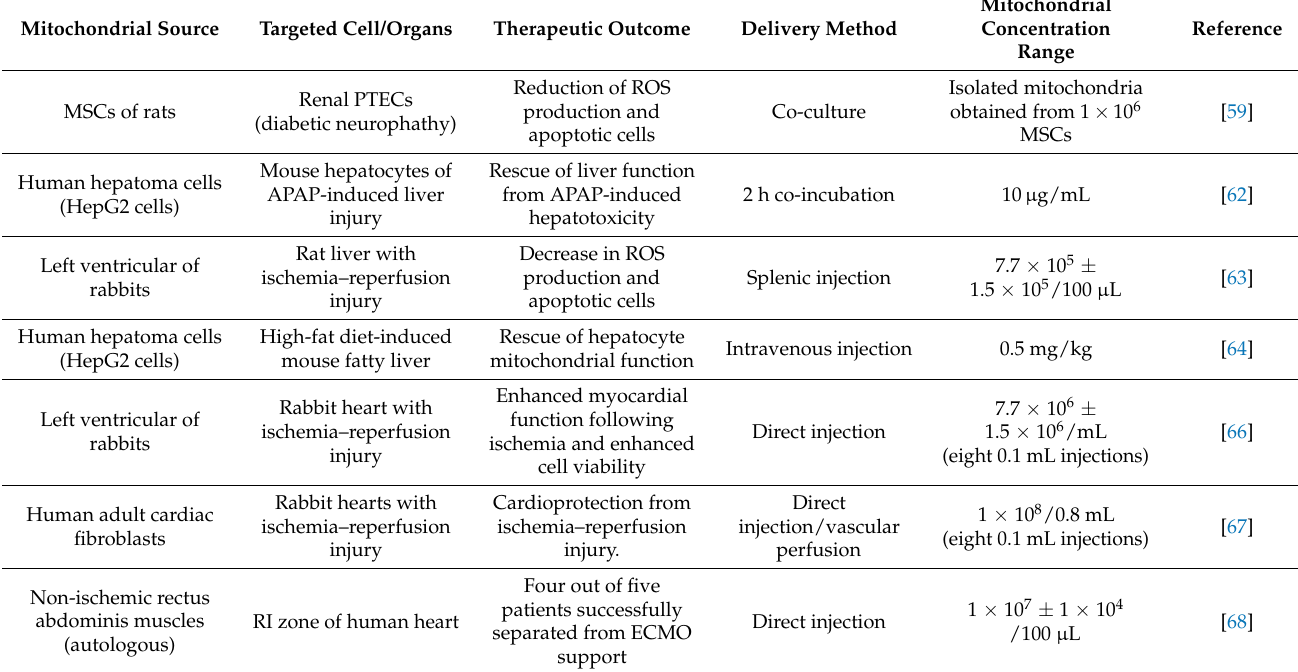
Table 2. Research reports of mitochondrial transplantation in diabetes and hepatic and heart